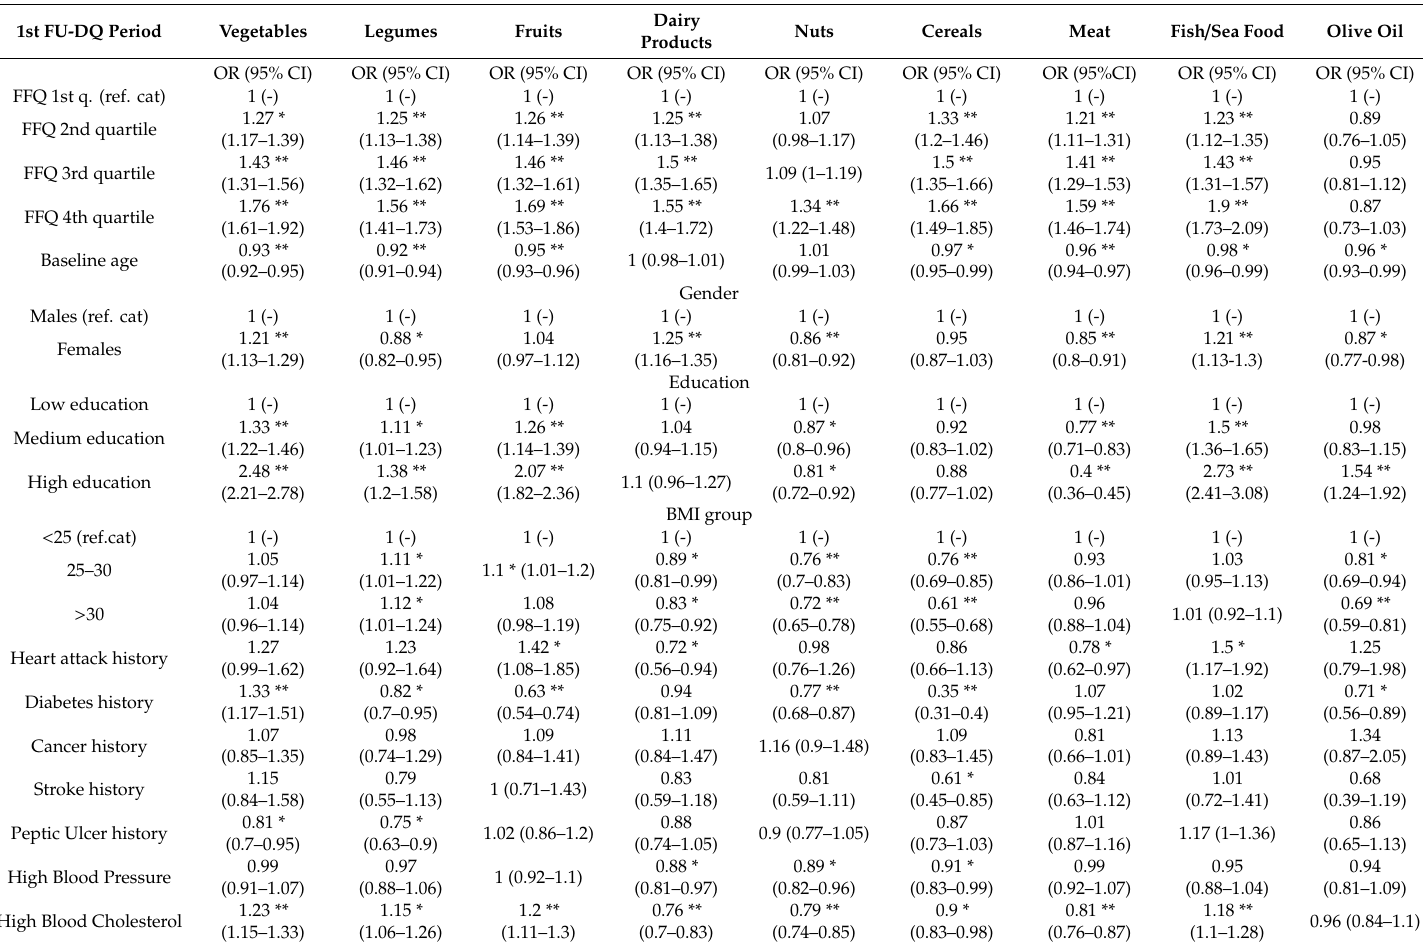
Table 4. Ordinal logistic regression performed on the food items / groups of interest for the 1 st FU-DQ. The ordinal response variable has three categories (“Much More / More”, “Same”, or “Less / Much Less”). The estimated measure is the Odds Ratio (OR). Confidence intervals of the estimations are also given